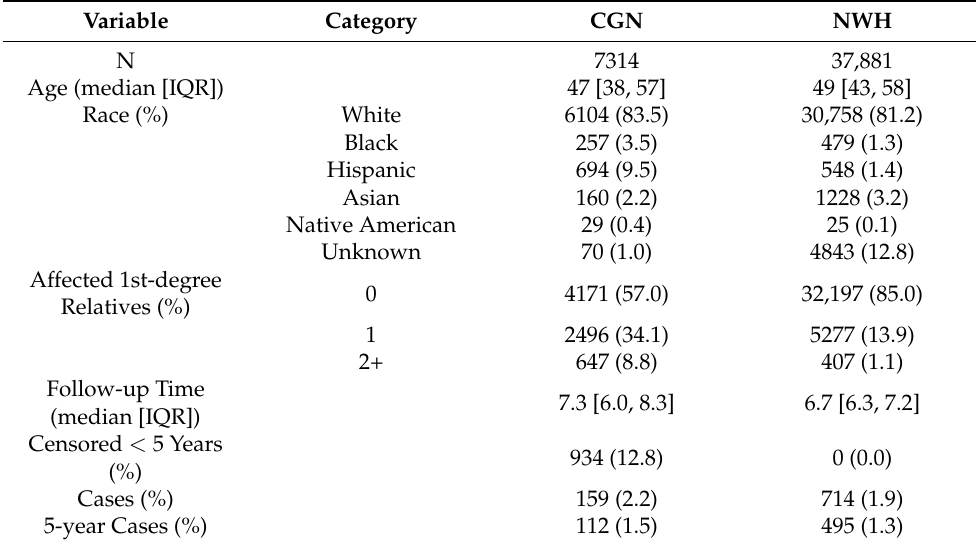
Table 1. Main characteristics of the CGN and NWH